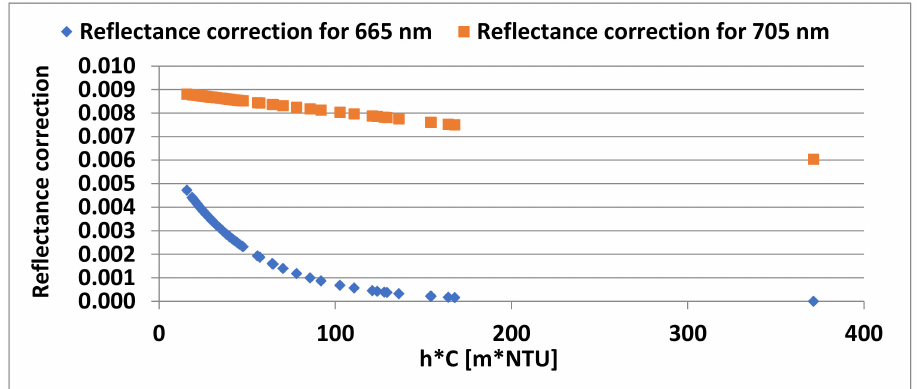
Figure 24. The reflection corrections graph versus the product of the depth and turbidity for the chlorophyll a model.